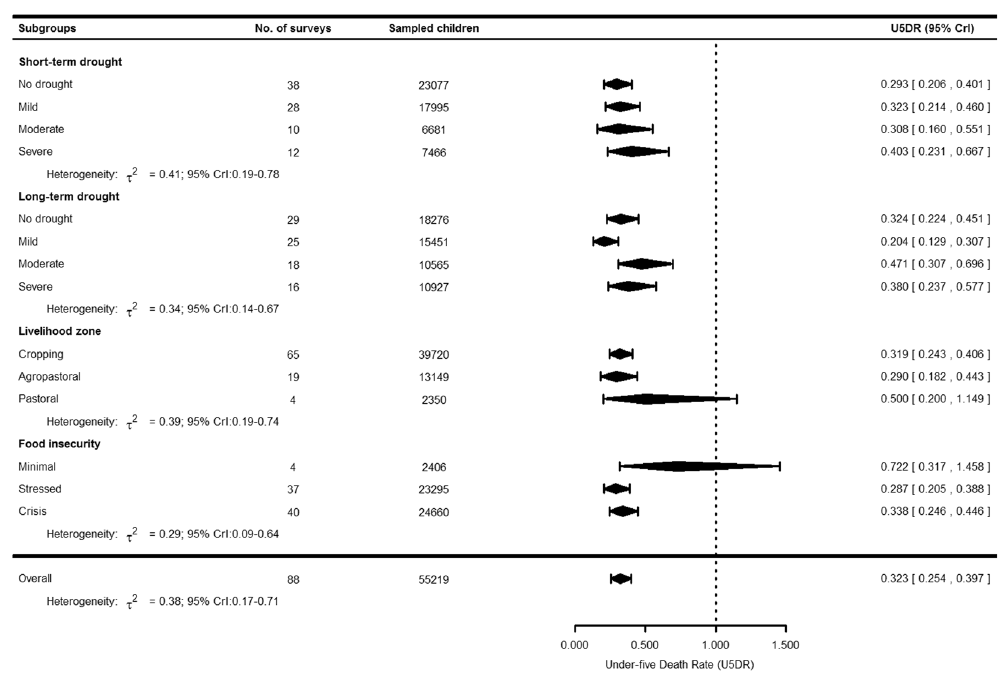
Figure 2. Forest plot showing the pooled U5DR and their 95% CrI’s, stratified by short- and long-term drought exposure levels, livelihood zones and food insecurity level from 88 small-scale mortality surveys from Ethiopia, 2009–2014. The U5DR was based on the small-scale retrospective household surveys 32 . The short- and long-term droughts in a given location were based on the 3- and 12-month standardized precipitation evapotranspiration index (SPEI), respectively 35 . Food insecurity was based on the integrated food security phase classification (IPC) 38 ; and it is available for 81 survey locations. Livelihoods are based on similarities in terms of economic activity, food source, and income and market opportunities. CrI: credible